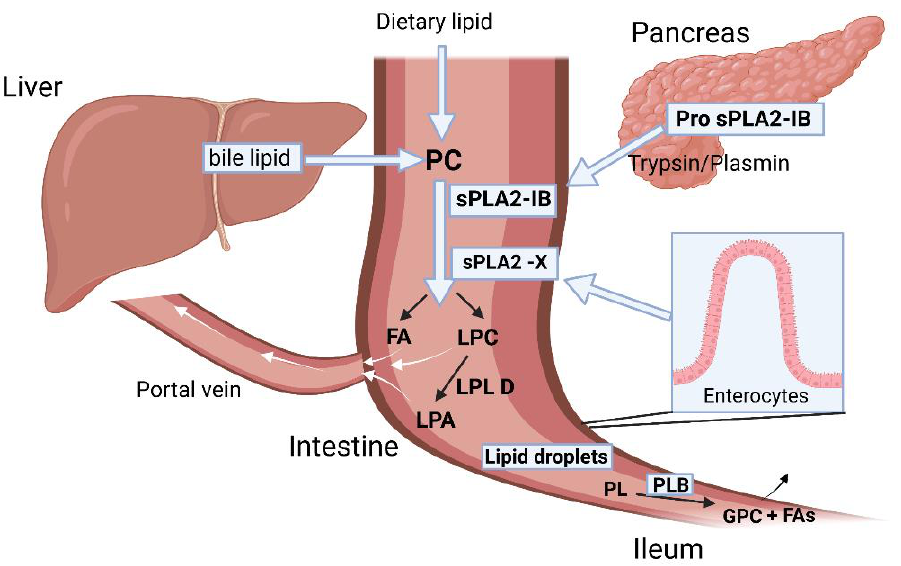
Figure 16. Physiologic role of phospholipases in GI tract. Pancreatic sPLA2-IB is secreted in pancreatic juice as a zymogen and activated by trypsin or plasmin in the intestinal lumen. sPLA2-X is secreted by the enterocytes of the intestinal lumen. Both pancreatic sPLA2-IB and enterocytic sPLA2-X hydrolyze dietary and bile-secreted phospholipids. Phospholipase B is secreted in the distal intestine and hydrolyzes the undigested phospholipids yielding glycerylphosphocholine and FAs. Created with